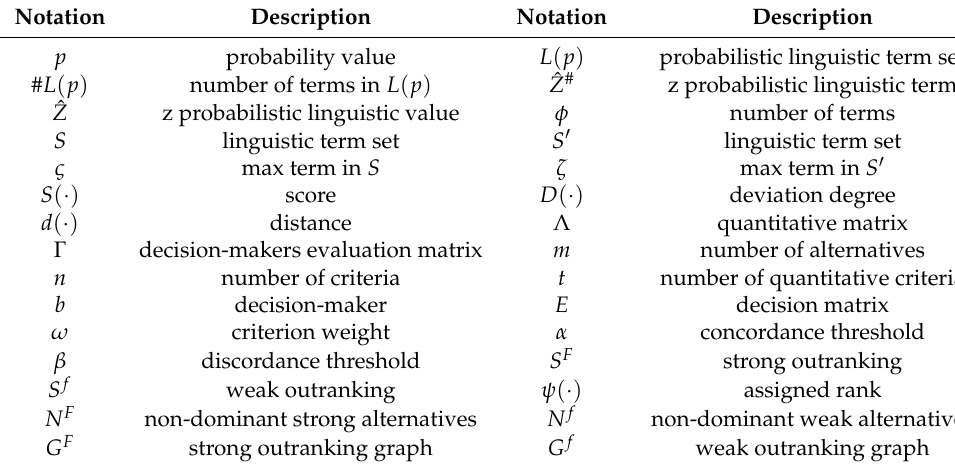
Table 1. Descriptions of mathematical symbols and